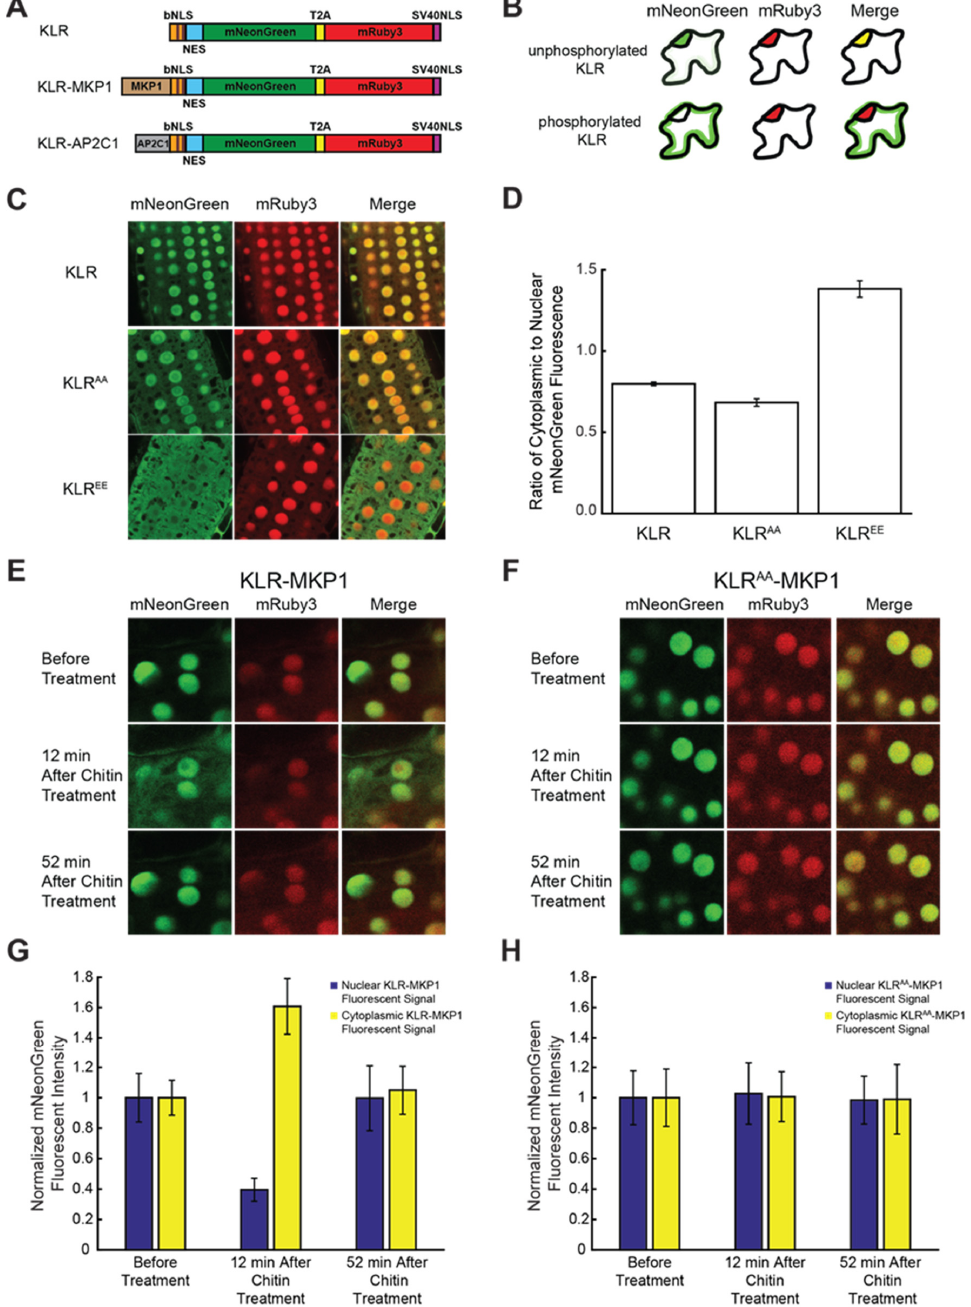
Figure 3. Functional characterization of the kinase localization reporter (KLR) kinase translocation reporter in Arabidopsis root cells. ( A ) Domain structure of KLR, KLR-MKP1, and KLR-AP2C1. bNLS is a bipartite modified nuclear localization signal derived from mouse C-Jun protein. The two phospho-acceptor sites (S63 and S73) are indicated by brown lines. NES is a consensus nuclear exclusion signal. mNeonGreen is a green fluorescent protein. T2A refers to the “self-cleaving” Thosea asigna virus 2A peptide. mRuby3 is a red fluorescent protein. SV40NLS is an NLS derived from simian virus 40 (SV40). Maps are not to scale ( B ) Cartoon of predicted KLR and mRuby3 localization. Unphosphorylated KLR is expected to localize to the nucleus, whereas phosphorylated KLR should be excluded from the nucleus. The nuclear marker mRuby3 is expected to constitutively localize to